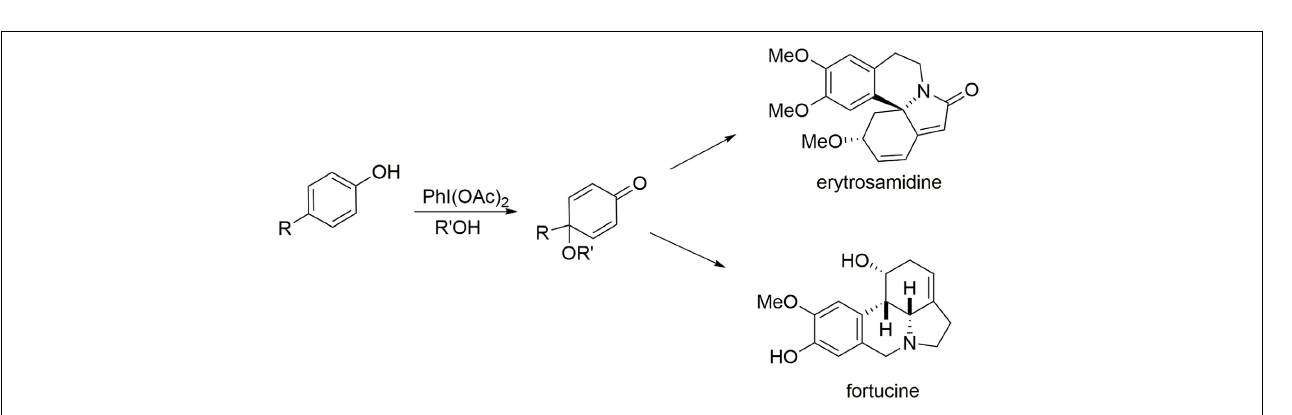
FIGURE 8 | Alkaloids bearing a cyclic trisubstituted